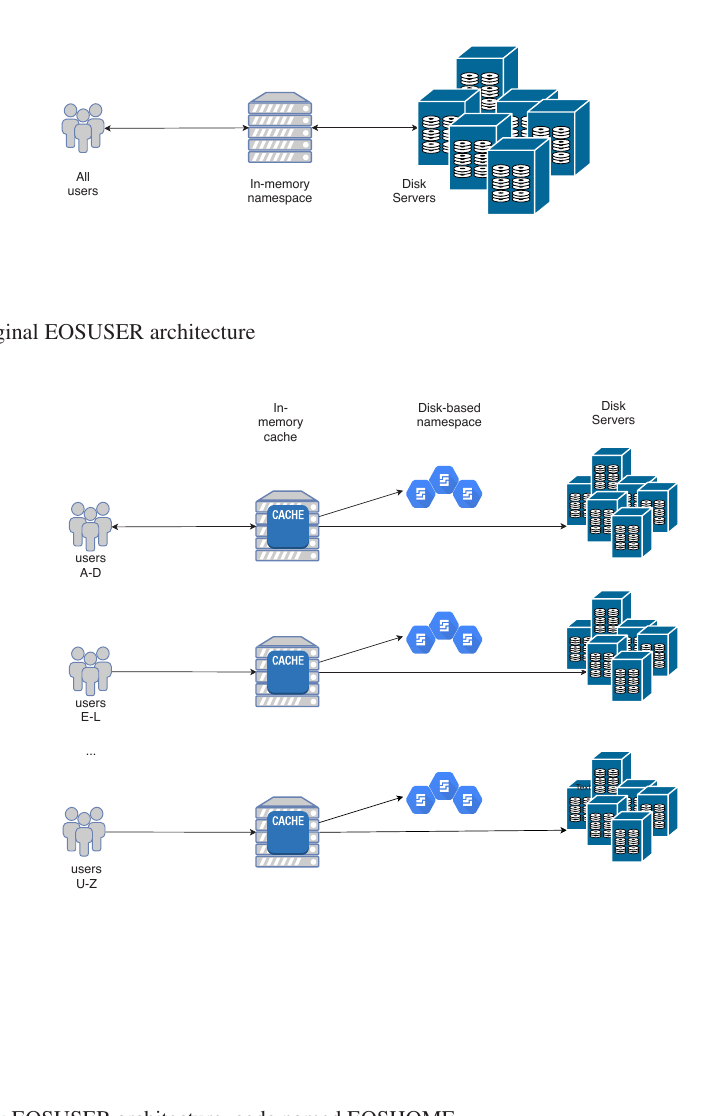
Figure 7. New EOSUSER architecture, code named